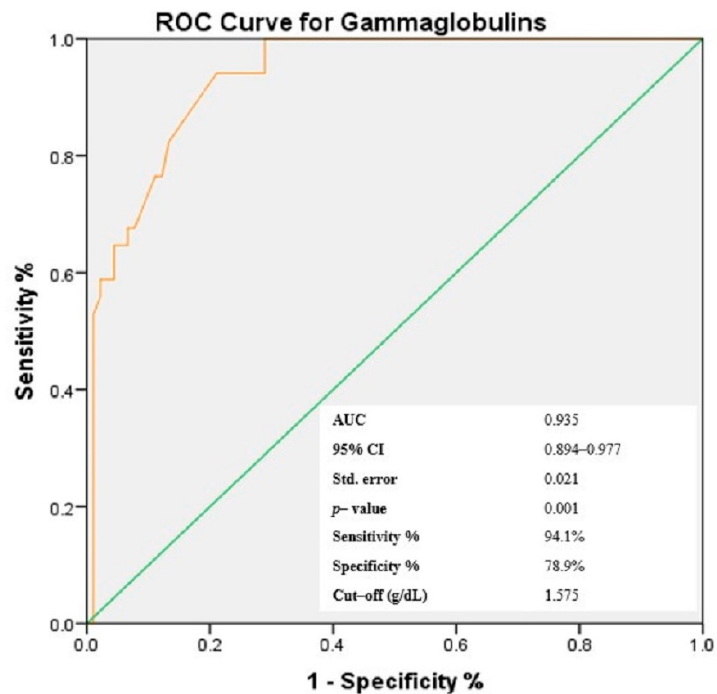
Figure 5. Receiver operating characteristic curve of gammaglobulins levels for the prediction of the cutaneous vasculitis lesions in patients with pSS.